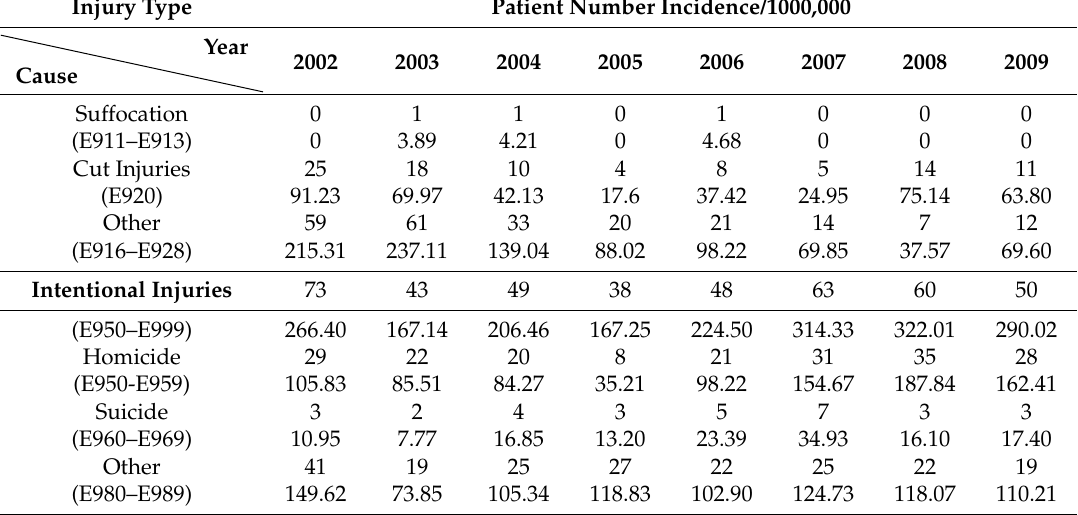
Figure 2. The temporal change of falls between 2002 and 2009.